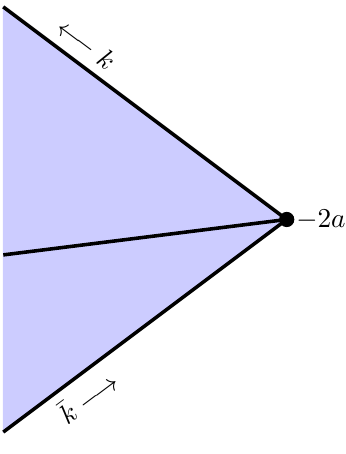
Figure 12 . Composition of null/null